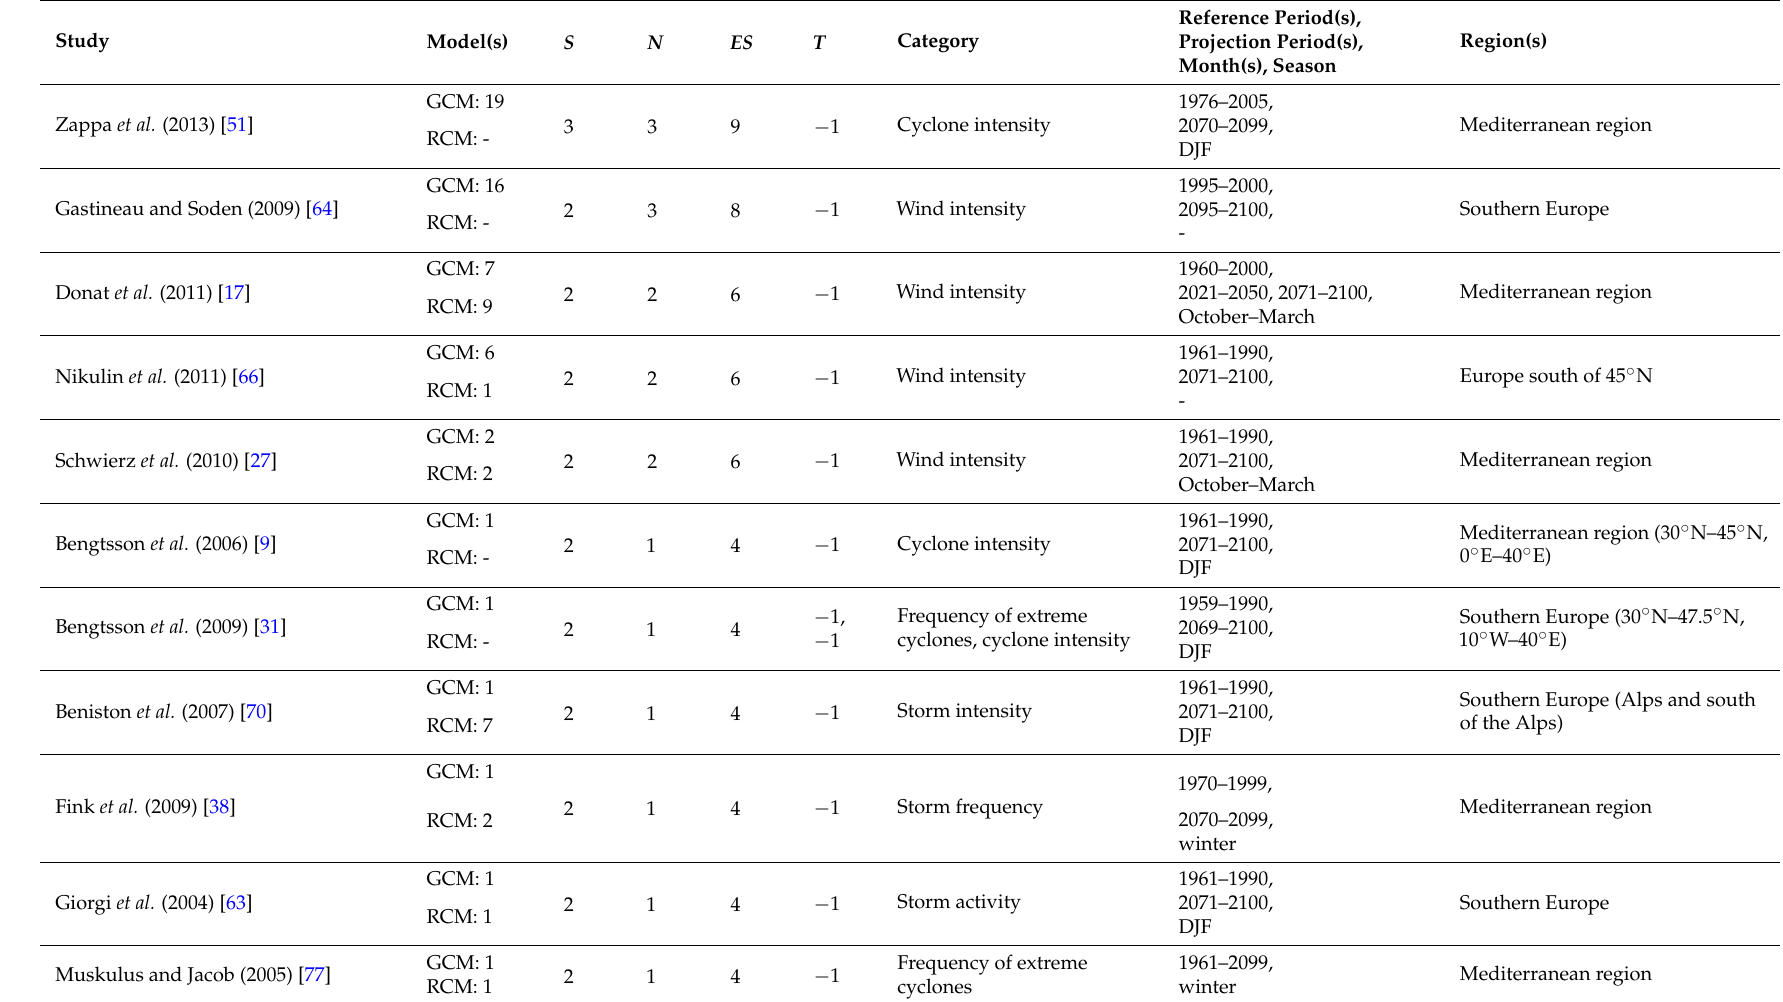
Table 5. Same as Table 1 but for the Southern Europe